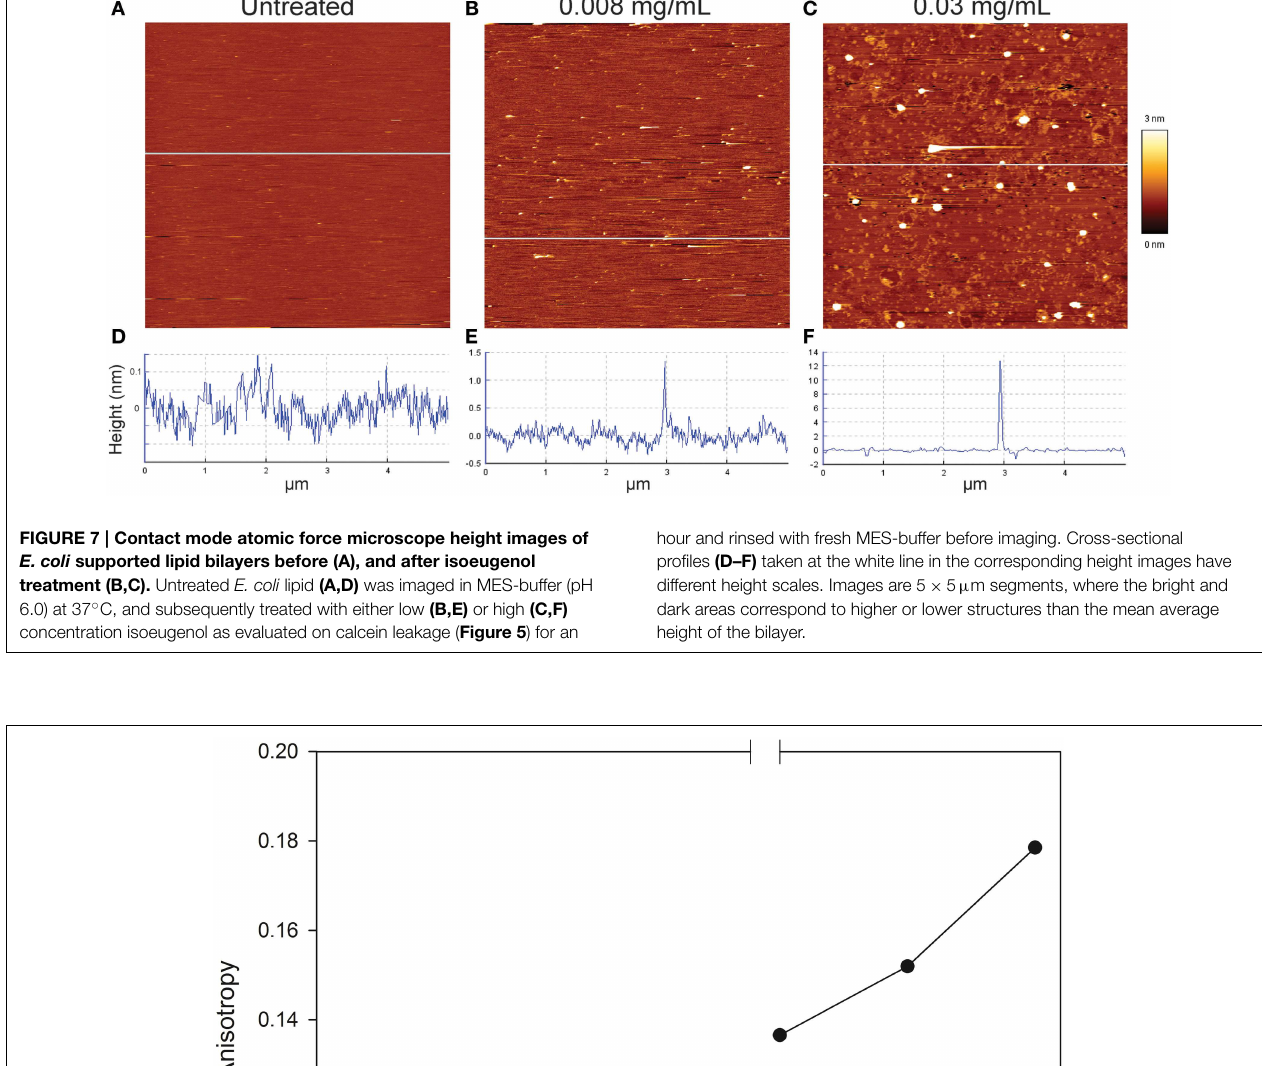
lipid ordering and bilayer fluidity, and an increased fluidity have a decrease in anisotropy, while low membrane fluidity has increases anisotropy signal. Mean anisotropy values are shown for duplicates of DOPG:DOPC (20:80) vesicles, while average values for E. coli vesicles are shown for triplicates. Error bars = SD ( n = 3